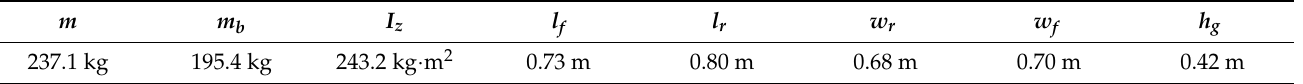
Table 1. The main parameters of the narrow tilting